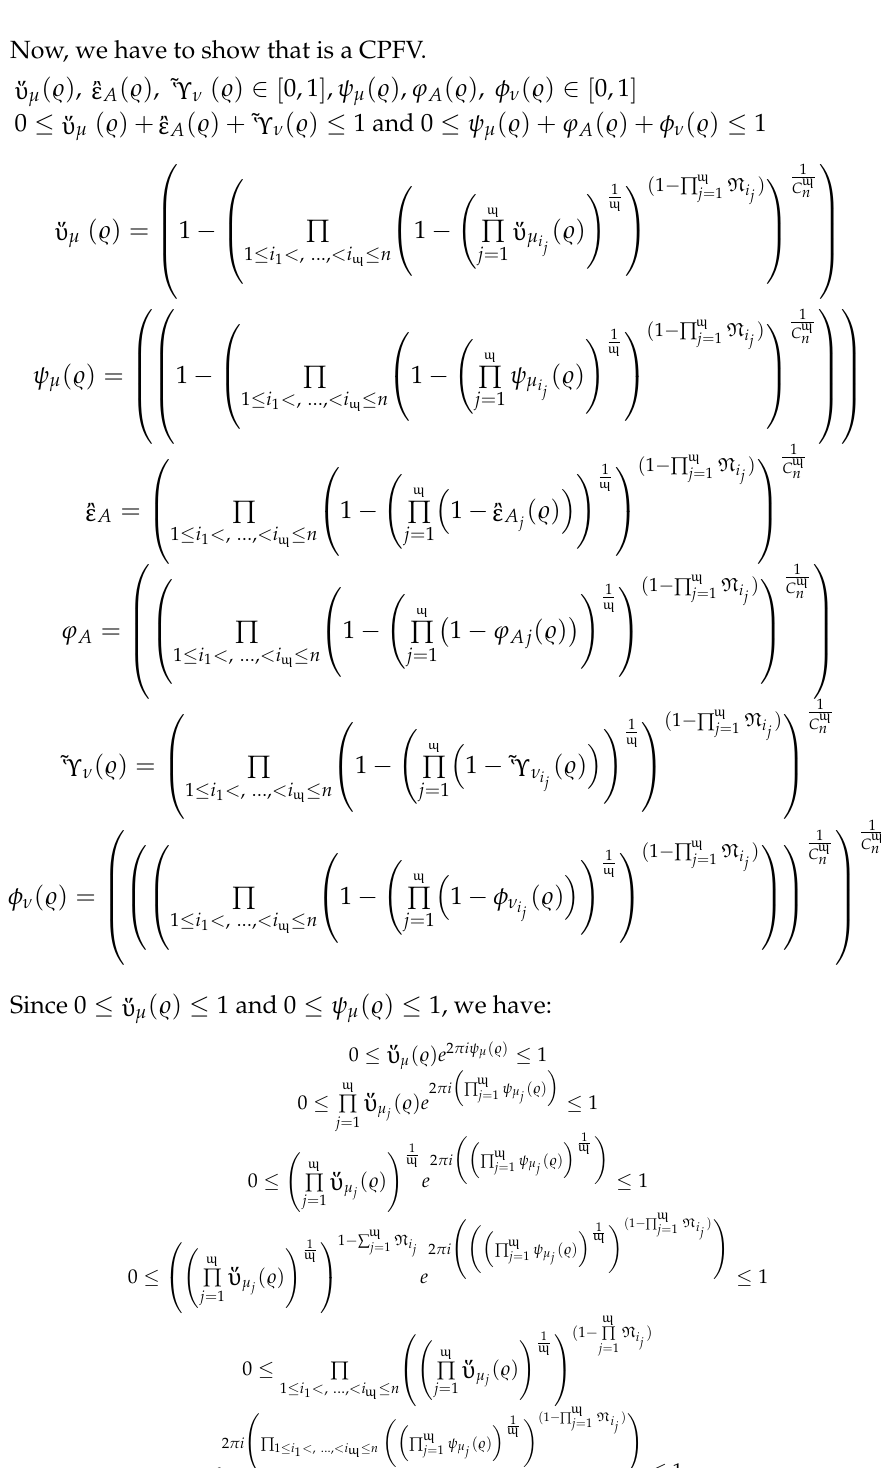
Table 1. Symbols and their meanings.